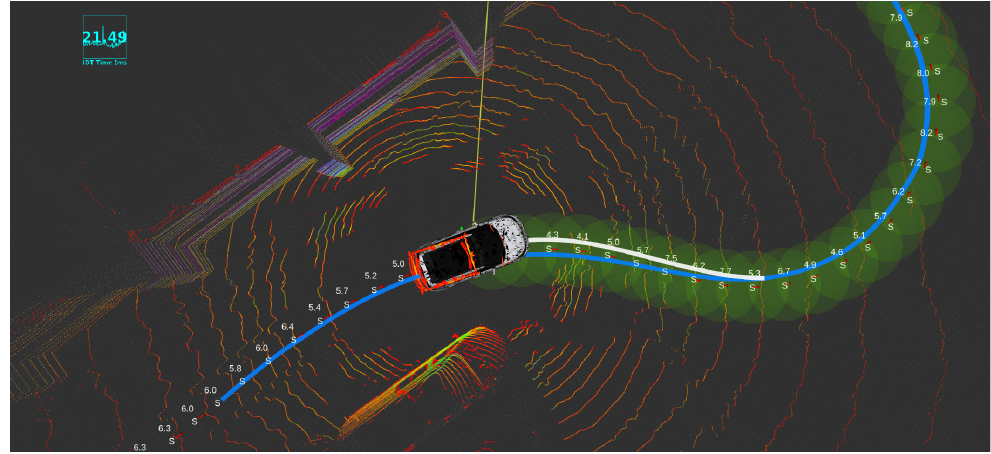
Figure 10. Egomotion planning using